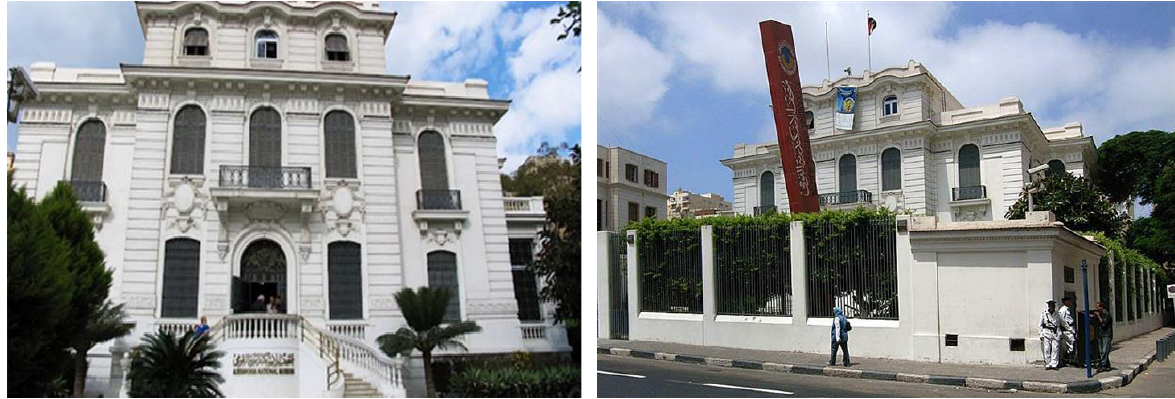
Figure 10: Alexandria National Museum (formerly known as Basili Palace), El-Horeya Road - Alexandria (Home-SIS.,